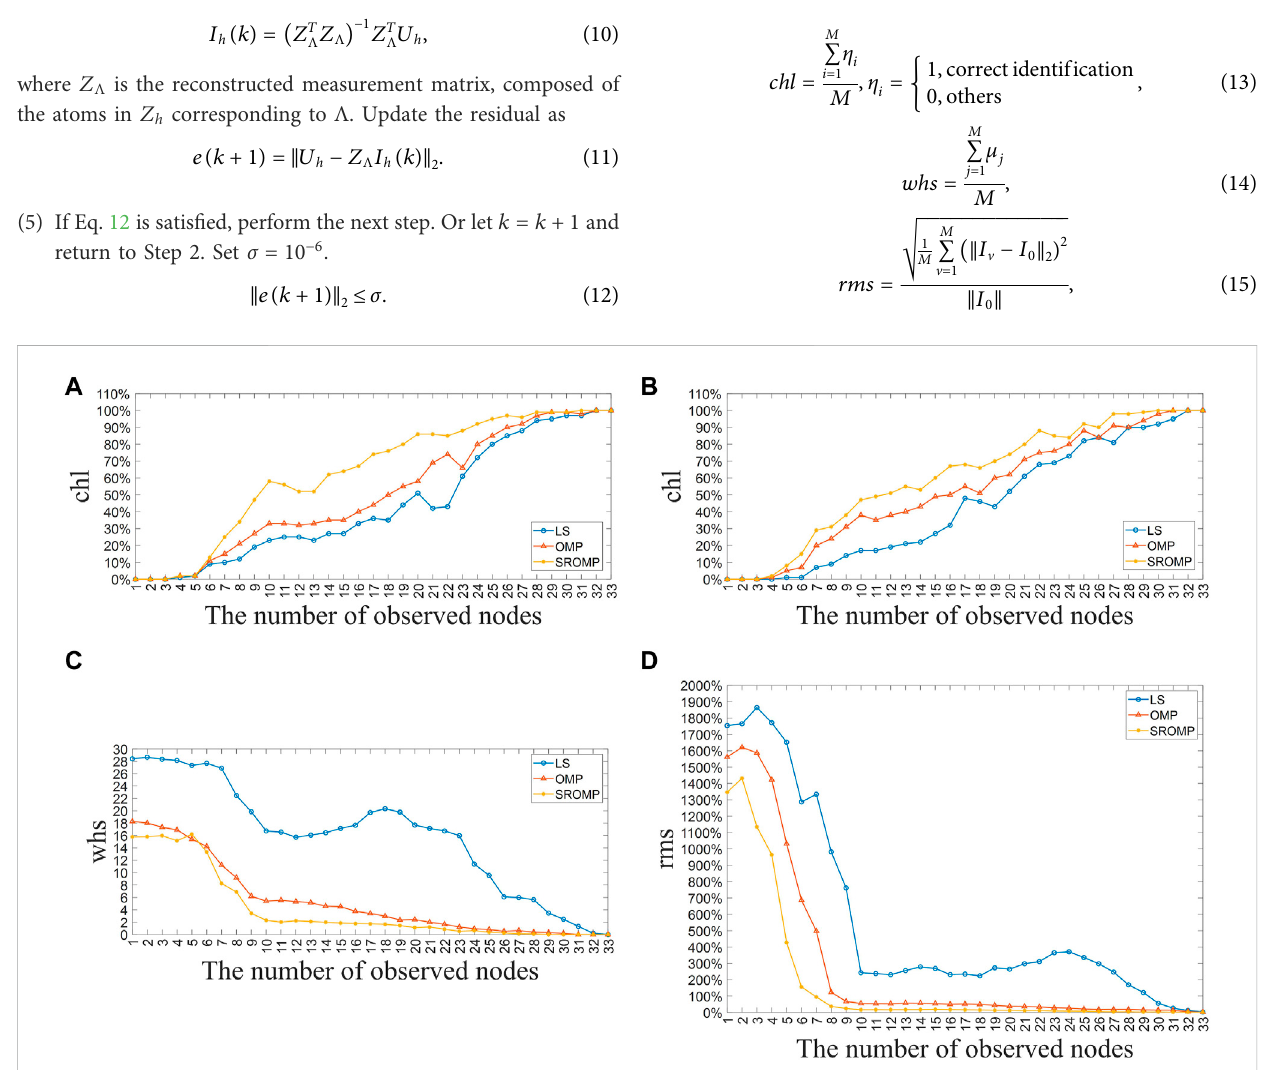
FIGURE 4 Analysis result of 5th harmonic. (A) chl of Node 14. (B) chl of Node 19. (C) whs of 5th harmonic. (D) rms of 5th